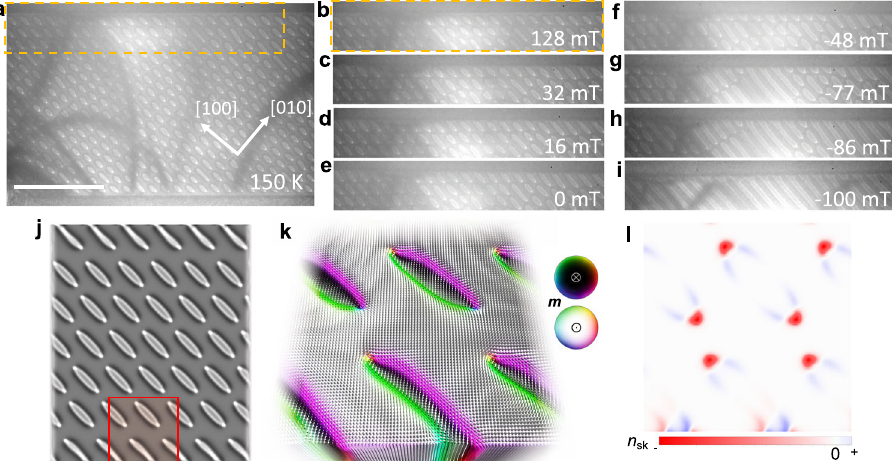
Fig. 2 Formation of fractional elliptical Bloch skyrmions. a A lattice of elliptical Bloch skyrmions at 128 mT and 150 K. b The region identi fi ed by the dashed orange rectangle in ( a ) is shown in ( b – i ). c At 32 mT, fractional Bloch skyrmions start to form at the interface with PtC x . d , e The number of fractional nano-objects increases when the elliptical Bloch skyrmions enlarge and join the interface. f In negative fi elds, the size of the elliptical skyrmions can decrease because the bulk elliptical skyrmions enlarge. g , h Upon further increasing the negative fi eld, the fractional nano-objects start to merge with the bulk elliptical Bloch skyrmions and form helices. i A helical state is found everywhere including the interface region. The scale bar in ( a ) corresponds to 2 μ m. j Simulated LTEM contrast of an elliptical skyrmion lattice with fractional objects at the top and bottom edges that was stabilized in micromagnetic simulations. Periodic boundary conditions have been applied along the horizontal direction. k A magni fi ed view of the magnetic texture of the red area with arrows and colors indicating the orientation of the magnetic moments. l The topological charge density of the spin texture in ( k ). 0 mT, the antiskyrmions that are closest to the edge have turned Fig. 1a. The antiskyrmions have the same square-shaped into fractional objects (Fig. 1d). Upon applying negative magnetic contrast that we have analyzed in our previous study 23 . This fi elds in Fig. 1e, f, the bulk antiskyrmions become more and more deformation is a signature of the dipole-dipole interaction and square-shaped because their size would increase if they were not the anisotropic DMI 29 . Due to these interactions, the square- shaped antiskyrmions form a square lattice. This antiskyrmion con fi ned by the neighboring antiskyrmions. This pushes the lattice reaches close to the edge, which is an interface between fractional antiskyrmions, which now appear as triangles, even the magnetic Mn 1.4 Pt 0.9 Pd 0.1 Sn and the non-magnetic PtC x closer to the edge: They are square-shaped antiskyrmions that applied during the fabrication of the lamella. have been ‘ cut in half ’ . Upon further increasing the magnitude of In the following, we concentrate on this region of the sample the negative fi eld, the fractional antiskyrmions merge among (orange border; shown also in Fig. 1b) and discuss the texture themselves forming a polarized region in the vicinity of the edge, upon decreasing the magnetic fi eld. In Fig. 1c the fi eld is 64 mT while the bulk antiskyrmions also merge and turn more and more and the size of the square-shaped antiskyrmions has increased. At into helices; cf. Fig. 1g – i.